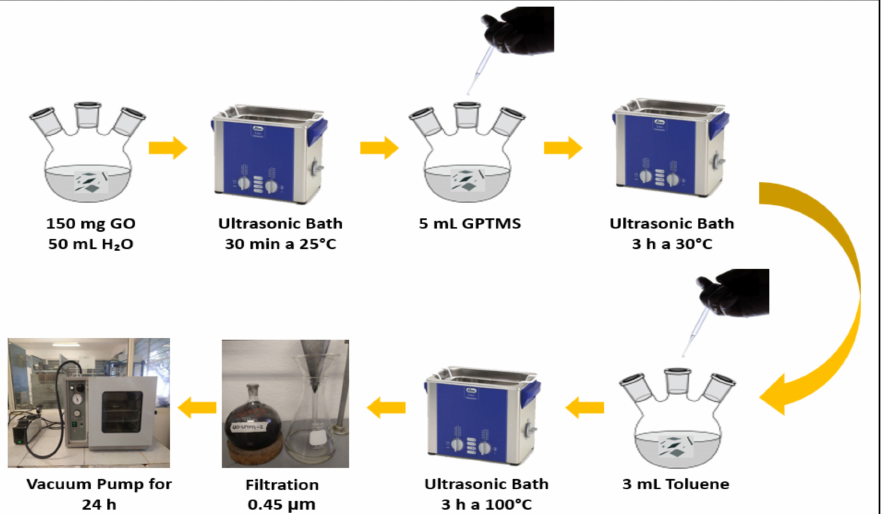
Figure 1. Functionalization process of GO with